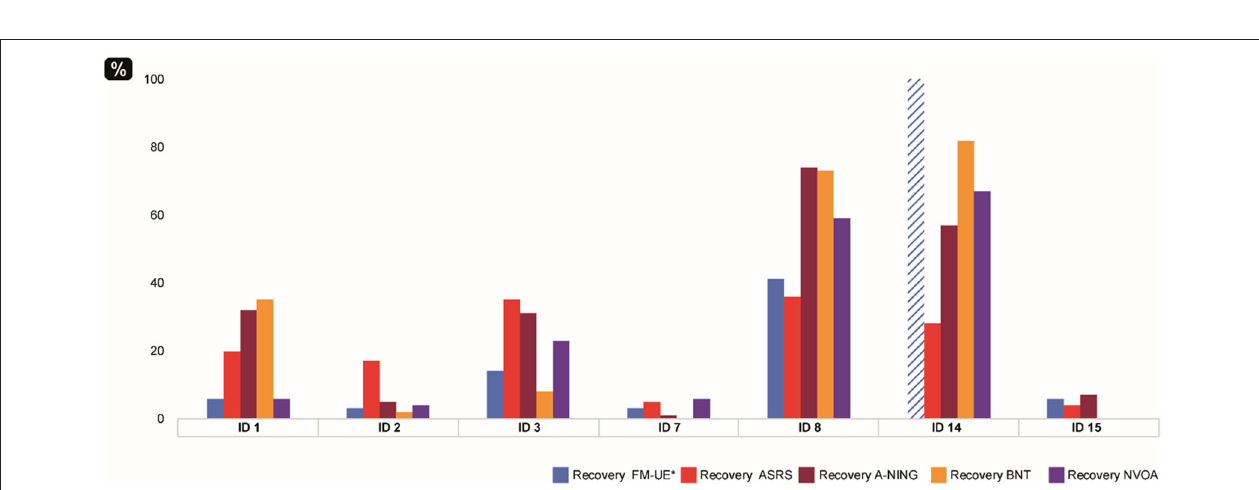
FIGURE 4 | Recovery ratios in participants with severe initial aphasia ( n = 7). *Blue striped plot shows FM-UE result at ceiling at A1.